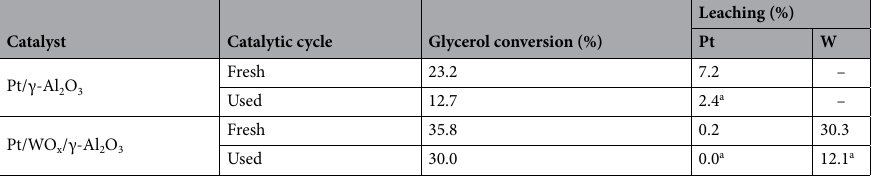
Table 1. The amounts of Pt and W leaching from the surface of catalysts in the reaction solution based on the catalyst used. a Leaching of used catalysts was calculated based on remained Pt and W on catalysts after the first hydrogenolysis